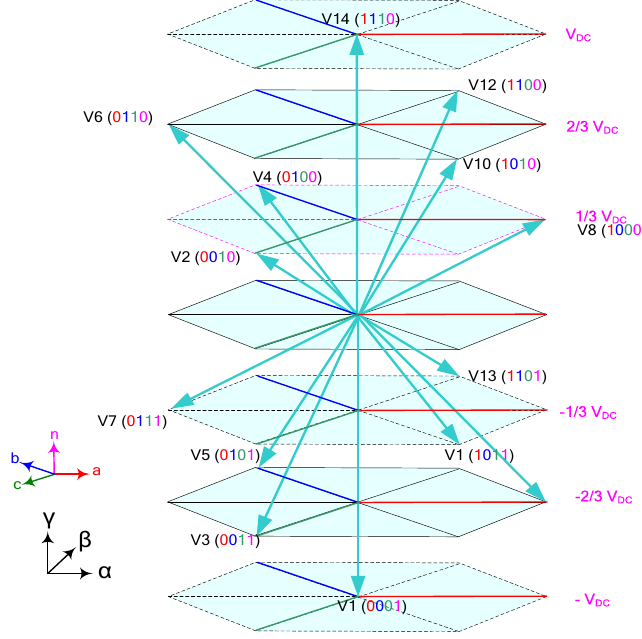
Figure 2. Three-dimension space vector pulse width modulation (3D-SVPWM) for a four-leg inverter.